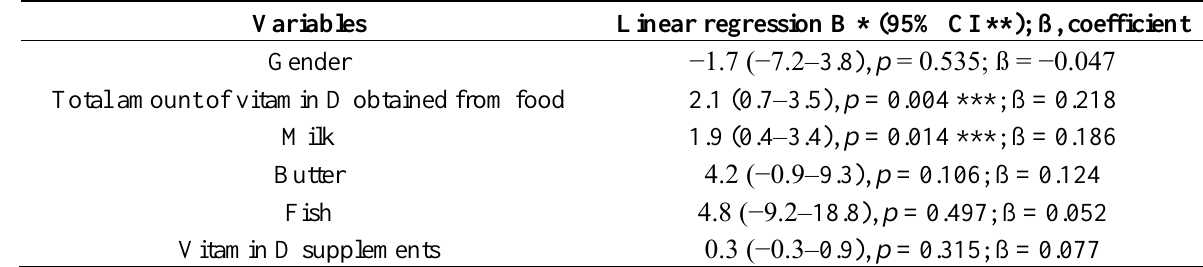
Table 3. Results linear regression.